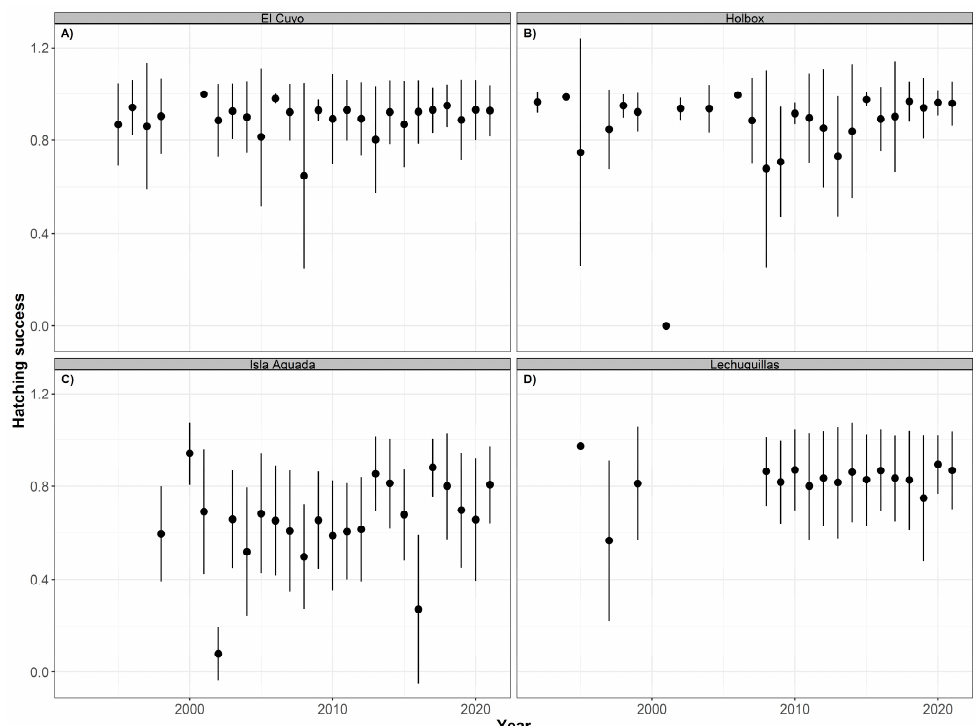
Figure 10. Time series of hatching success (annual mean ± SD) for green turtles ( Chelonia mydas ) nesting at El Cuyo ( A ), Holbox ( B ), Isla Aguada ( C ), and Lechuguillas ( D ) from 1990 to 2021.